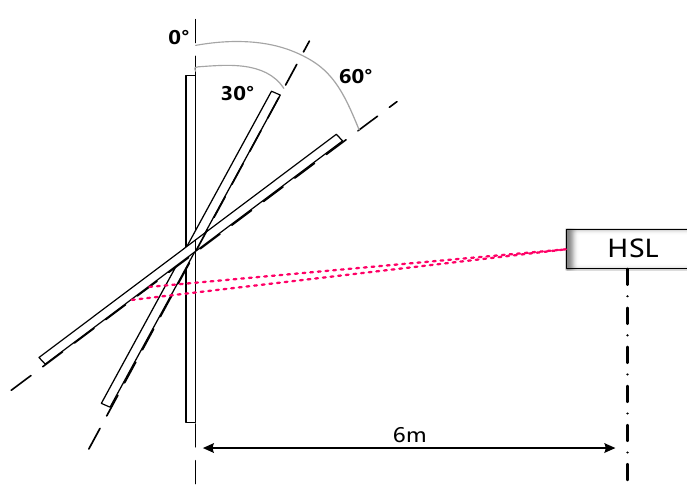
Figure 2. Measurement setup of experiment 1 with a fixed distance of 6 m is scanned at varying incidence angles. A representative laser beam is depicted in red.